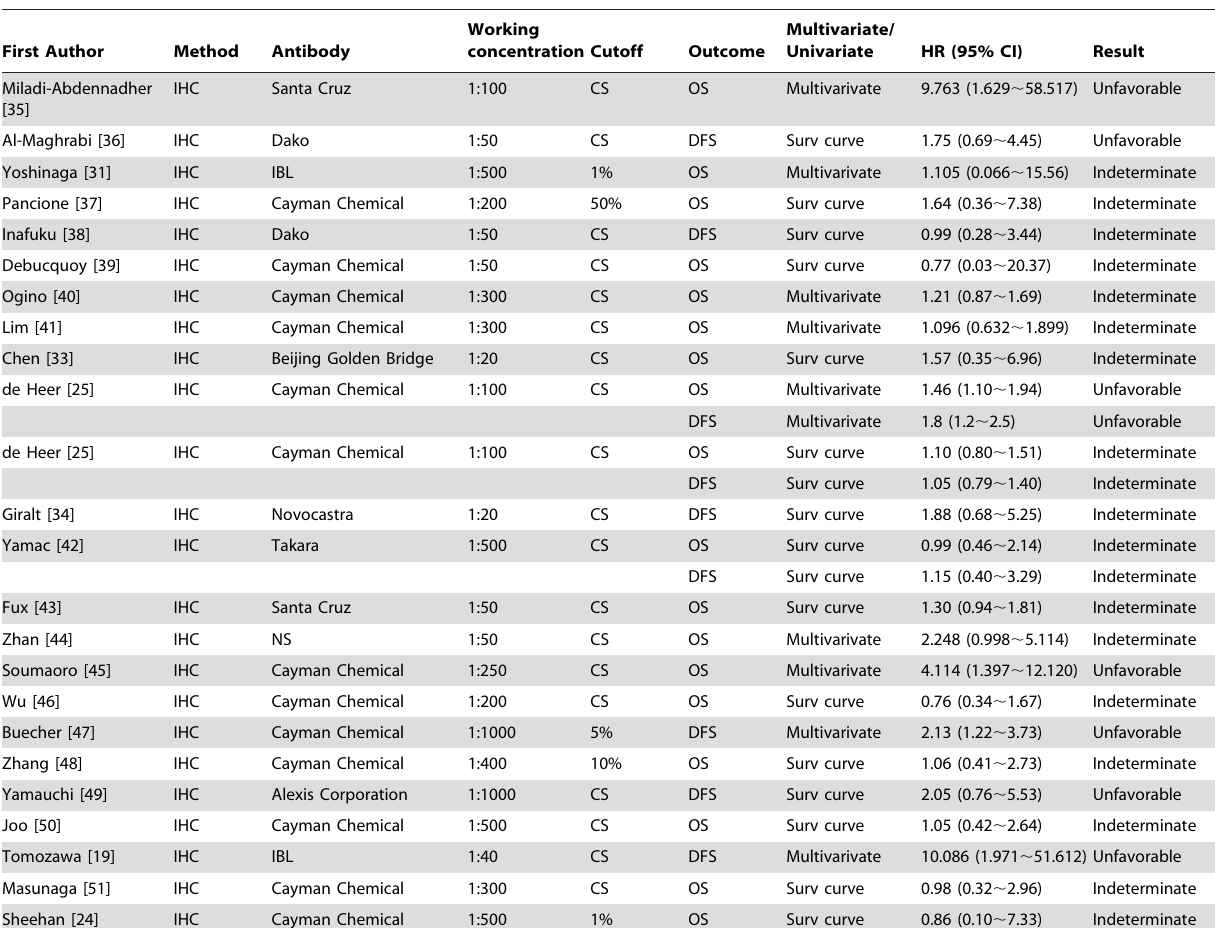
Summary table of studies included in the meta-analysis. Results were either unfavorable (95% CI above 1.0) or indeterminate (95% CI crossing 1.0). Abbreviations: COX- 2, Cyclooxygenase-2; N, number of patients; Surv curve: survival curve; IHC, immunohistochemistry; OS, overall survival; DFS, disease-free survival; CI, confidence interval; CS, complex score combining intensity and percentage; NS, not specified.